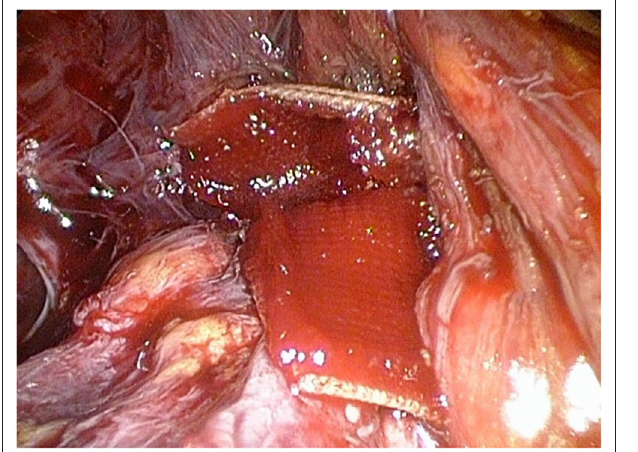
TABLE 1 | Timeline of relevant diagnostics and